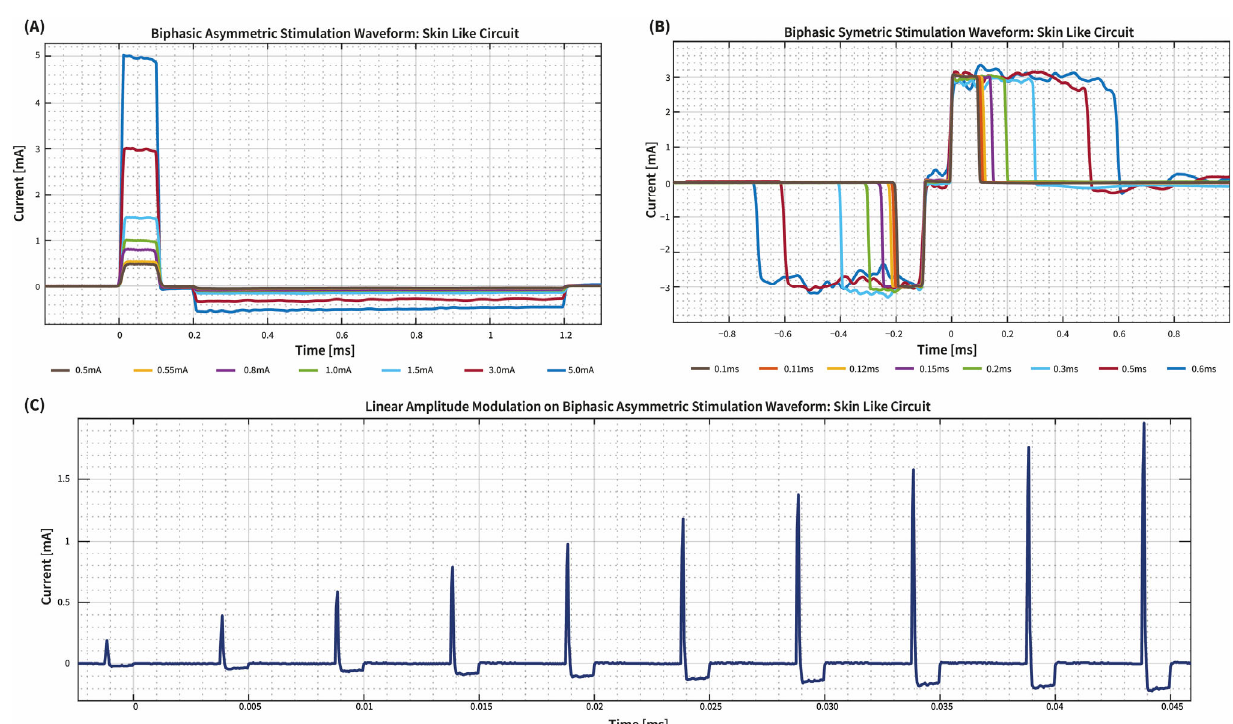
Figure 6. Stimulation on Skin ‐ like circuit using ( A ) Biphasic asymmetric waveform with different amplitude and pulse width 100 μ s ( B ) Biphasic symmetric waveform with different pulse width and amplitude 3.5 mA ( C ) Linear amplitude modulation with Biphasic asymmetric waveform in the range 0.2 mA–2 mA, pulse width of 100 μ s, and frequency 200 Hz.